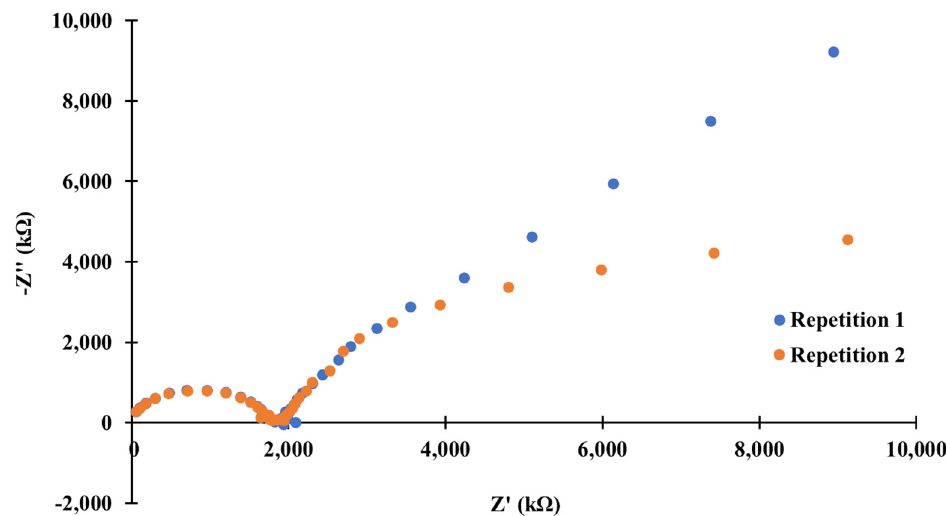
Figure 5. Impedance spectra of the studied solid-contact potassium-selective electrode with JUK- 13_H2O as an ion-to-electron transducer.